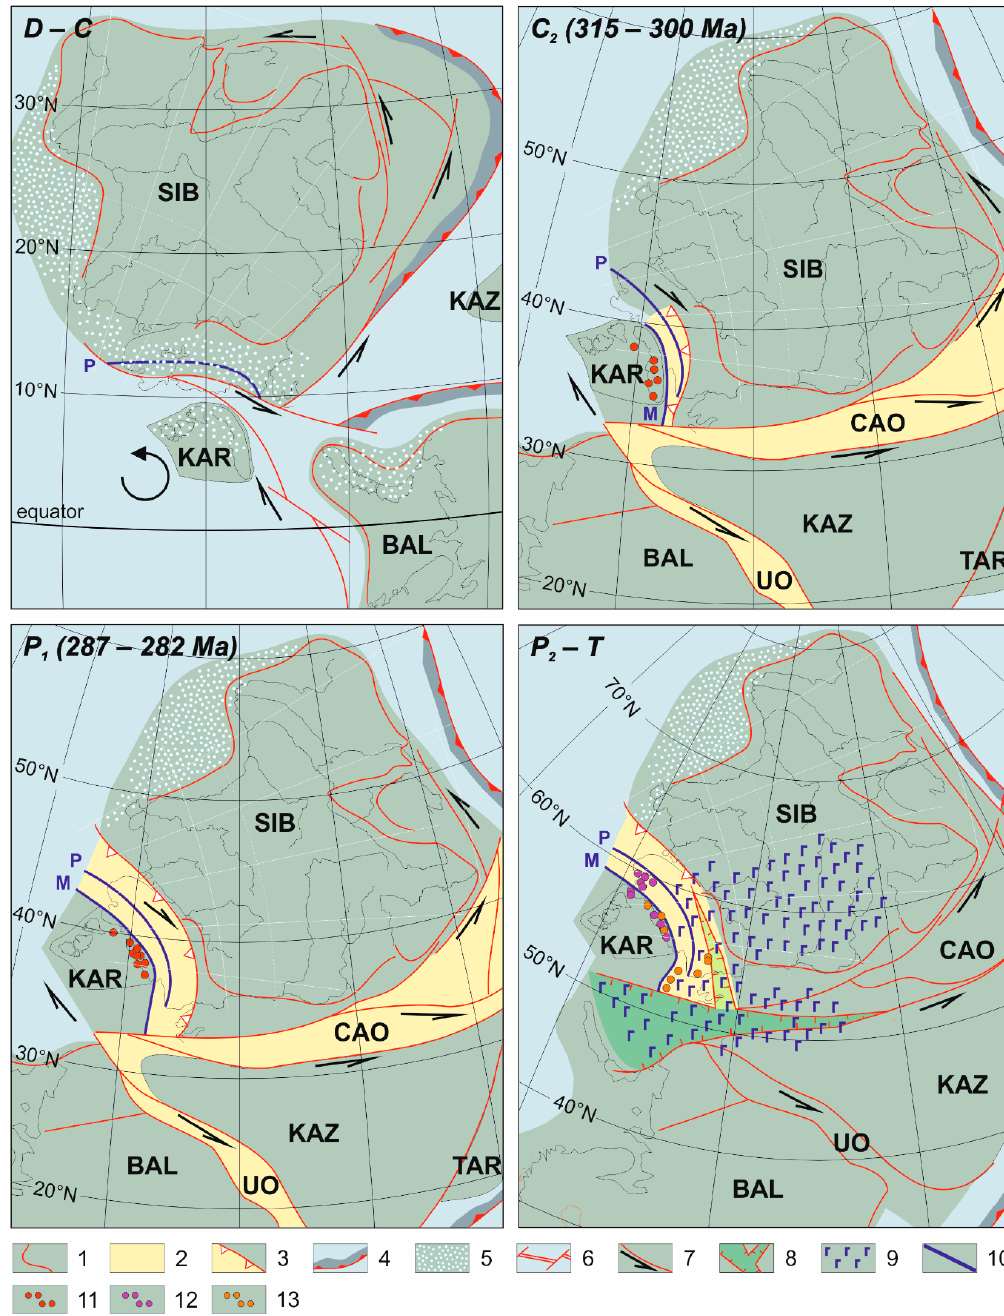
Figure 19. Paleotectonic reconstructions of the formation of the Kara orogen modified from [35]. 1— contours of continental blocks; 2—orogens in formation; 3—orogens deformation front; 4— subduction systems including volcanic belts and back arc basins; 5—passive continental margin shelf;